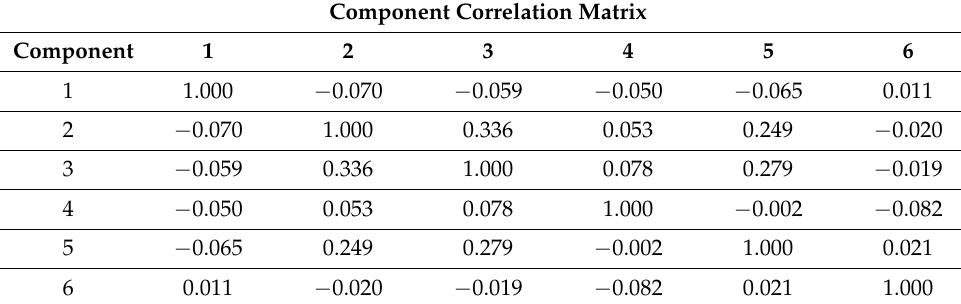
Table 8. Factor correlation matrix.